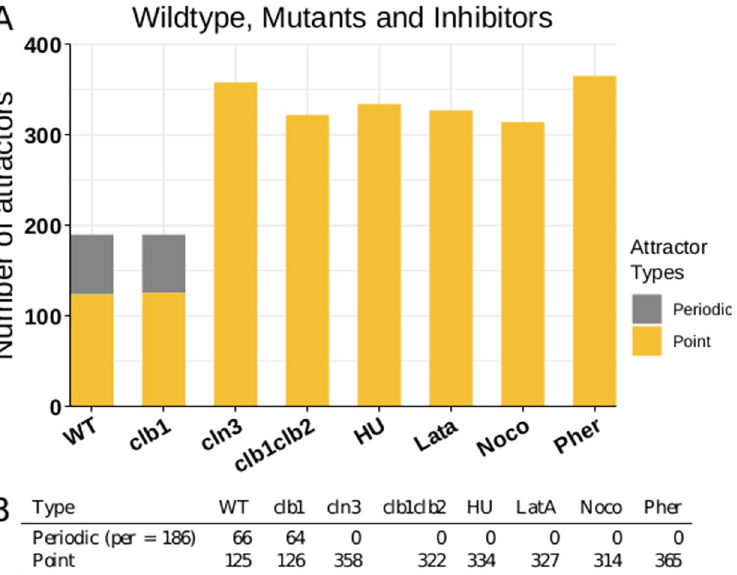
Fig 4. Attractor analysis results of cell cycle control network. Attractor analysis result of a bBM cell cycle control network with n = 3158 nodes. Results from in total eight initial guesses are shown: the wildtype genotype, the clb1 genotype with a corresponding viable phenotype, the cln3 genotype with a corresponding lethal phenotype (due to absence of Bcks2 in the underlying model), the clb1clb2 genotype with a lethal corresponding phenotype, and four initial guesses where one of the following cell cycle inhibitors is active, hydroxyurea, latrunculin, nocodazole, and pheromone. Several combiantions of a priori probabilities were used, representative results shown. (A) Barplot of the found types of attractors (point or periodic) for the eight initial guesses. (B) Data table. WT: wildtype, HU: hydroxyurea, Lata: Latrunculin A, Noco: nocodazole, Pher: Pheromone, per: